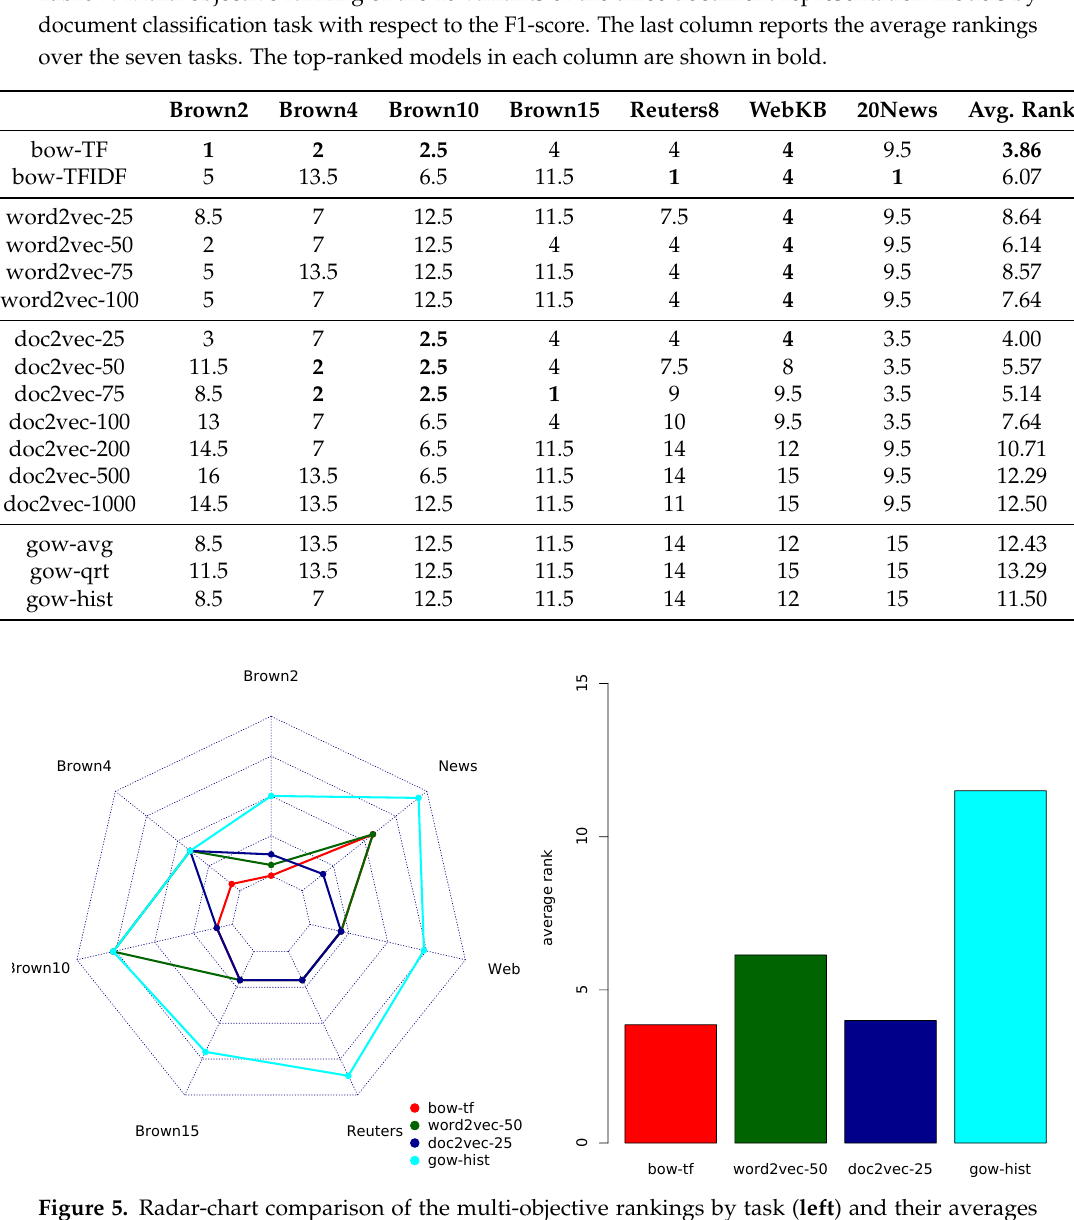
Figure 5. Radar-chart comparison of the multi-objective rankings by task ( left ) and their averages ( right ) for the four top-performing variants of the document representation models in each of the four groups with respect to